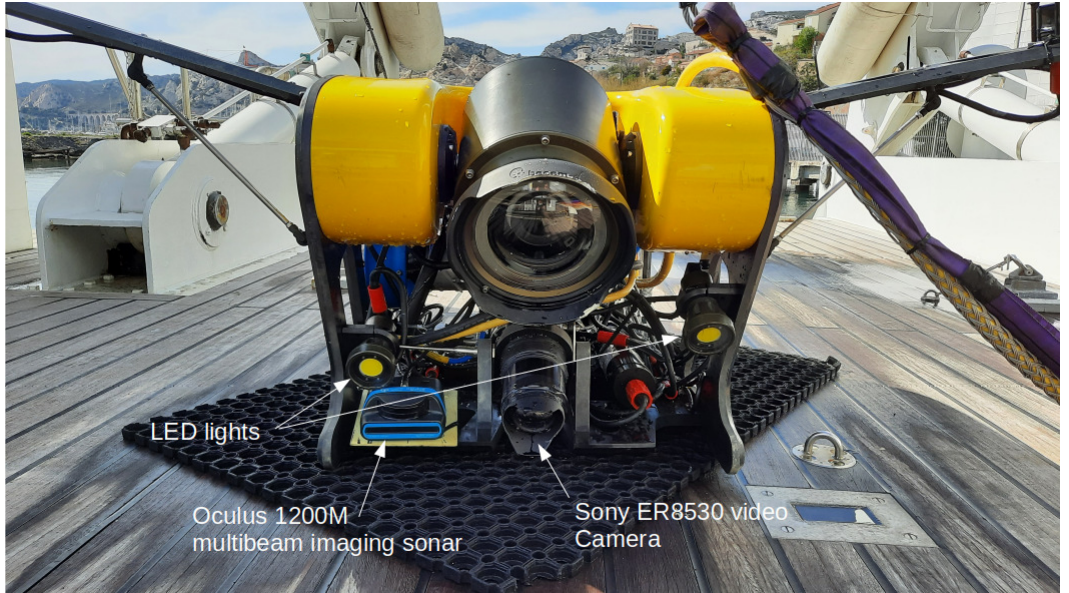
Figure 1. The Hilarion ROV of the DRASSM equipped with an acoustic camera (Oculus 1200M multibeam sonar from BluePrint Subsea) and a monocular video camera (Sony